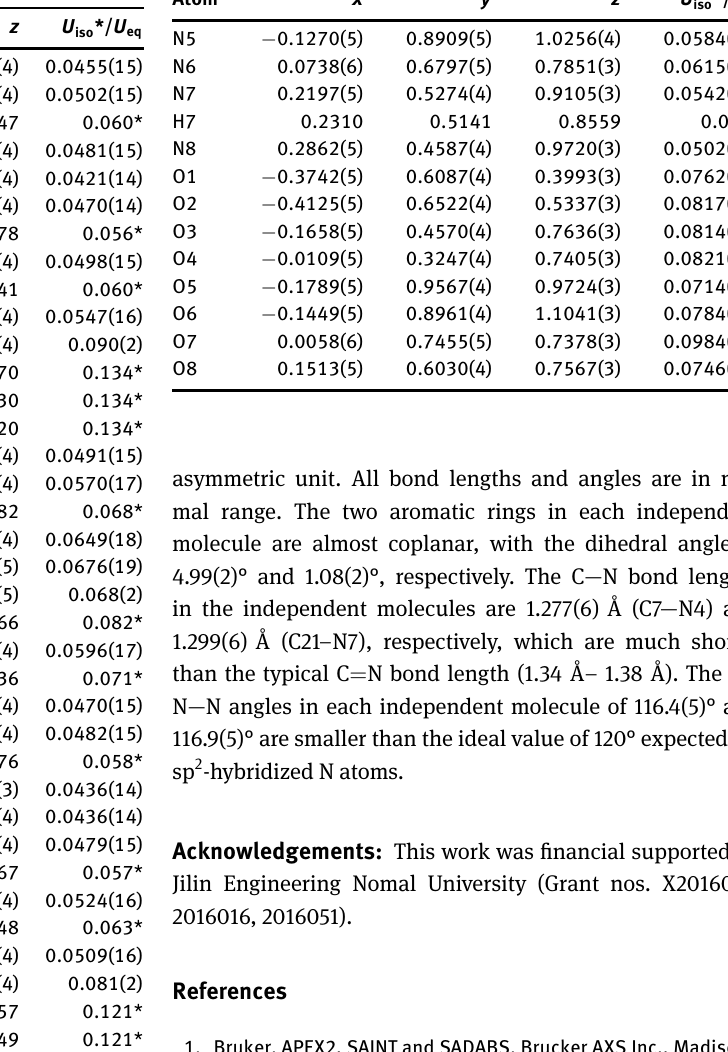
Table 2: Fractional atomic coordinates and isotropic or equivalent isotropic displacement parameters (Å 2 ).